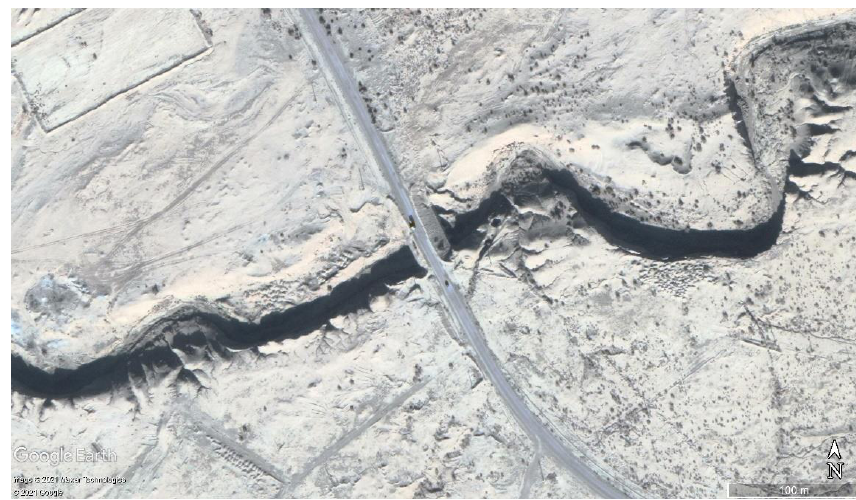
Appl. Sci. 2021 , 11 , x FOR PEER REVIEW Figure 20. The bridge No. 5 on Google Earth (Latitude: 35°31′59″ N, Longitude: 53°30′46″ E). Figure 20. The bridge No. 5 on Google Earth (Latitude: 35 ◦ 31 (cid:48) 59” N, Longitude: 53 ◦ 30 (cid:48) 46” E).